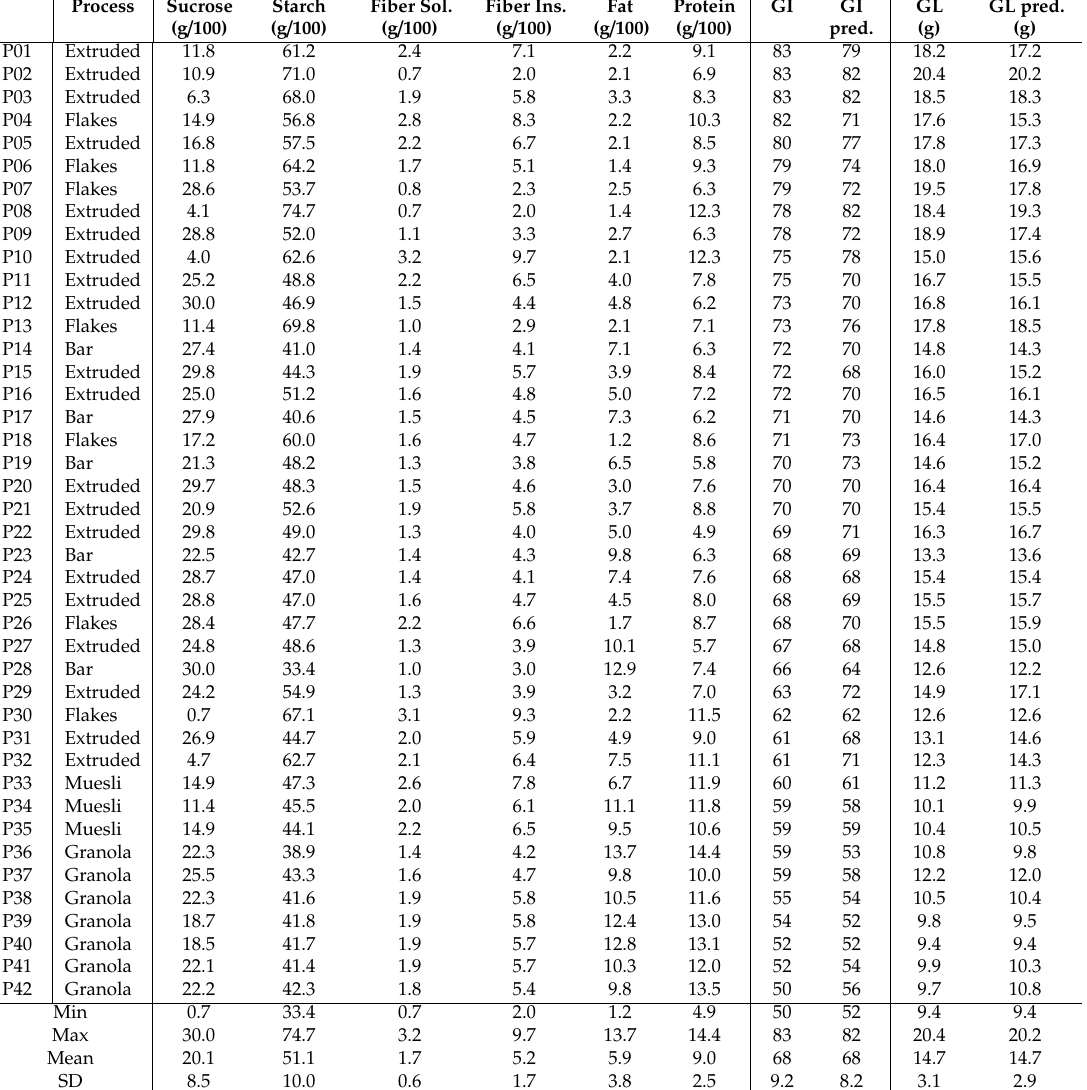
Table 1. 42 breakfast cereals with process, composition [g / 100 g], glycemic index (GI) (in-vivo vs. predicted) and glycemic load (GL) [g] for a 30 g serving (in vivo vs. predicted), sorted by descending